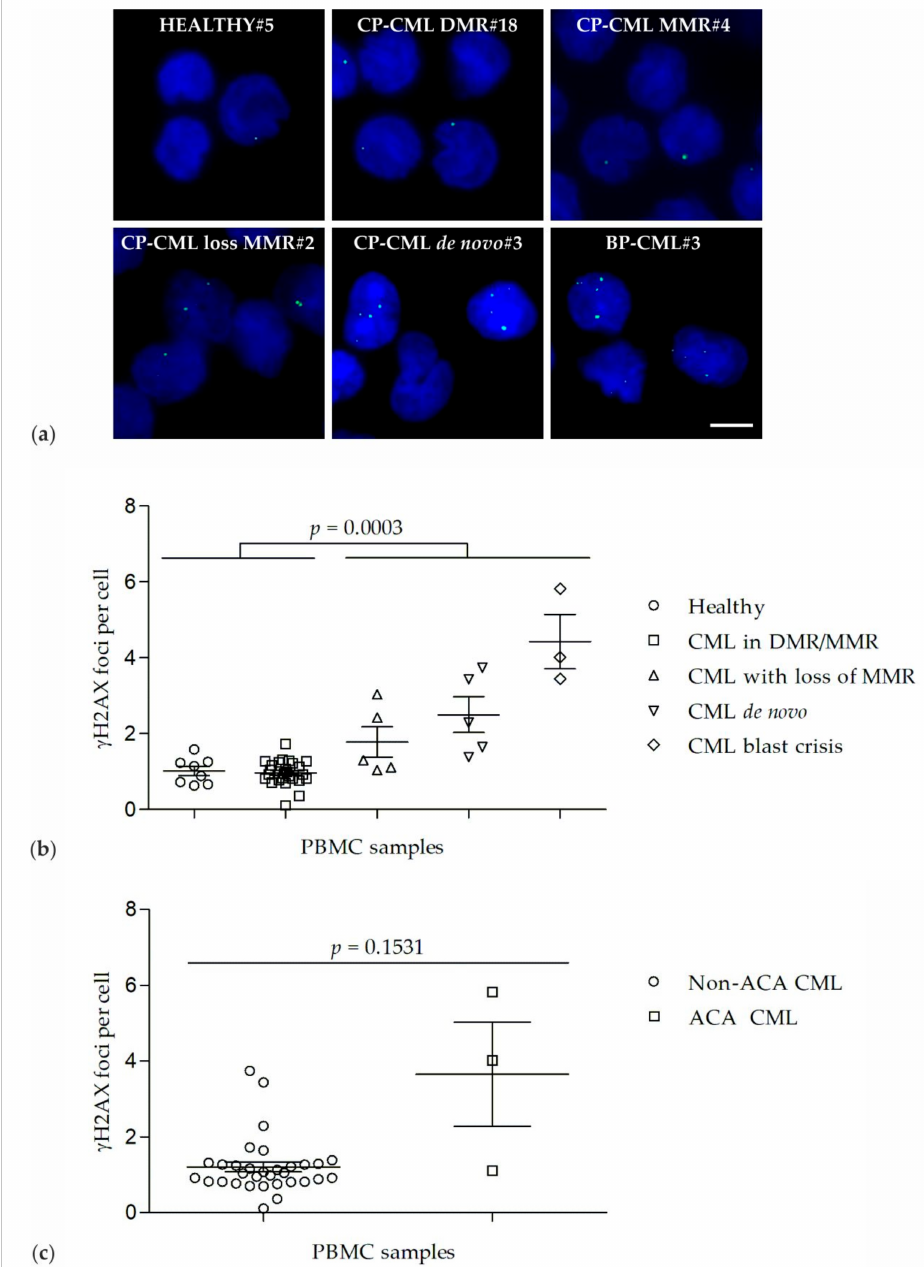
Figure 1. γ H2AX foci in peripheral blood mononuclear cells (PBMC) of healthy donors and CML patients. ( a ) Representative recordings of γ H2AX foci (green, Alexa 488) in PBMC nuclei (blue, DAPI) of a healthy donor (HEALTHY#5), a CP-CML patient with a DMR (CP-CML DMR#18), a CP-CML patient with a MMR (CP-CML MMR#4), a CP-CML patient with a loss of MMR (CP-CML loss MMR#2), a de novo untreated CP-CML patient (CP-CML de novo#3), and a BP-CML patient (BP-CML#3). Scale bar = 5 µ m. ( b ) γ H2AX foci counts in PBMCs of healthy donors and in PBMCs of CML patients at di ff erent stages. ( c ) γ H2AX foci counts in PBMCs of CML patients without additional chromosomal aberrations (Non-ACA CML) and in PBMCs of CML patients with additional chromosomal aberrations (ACA